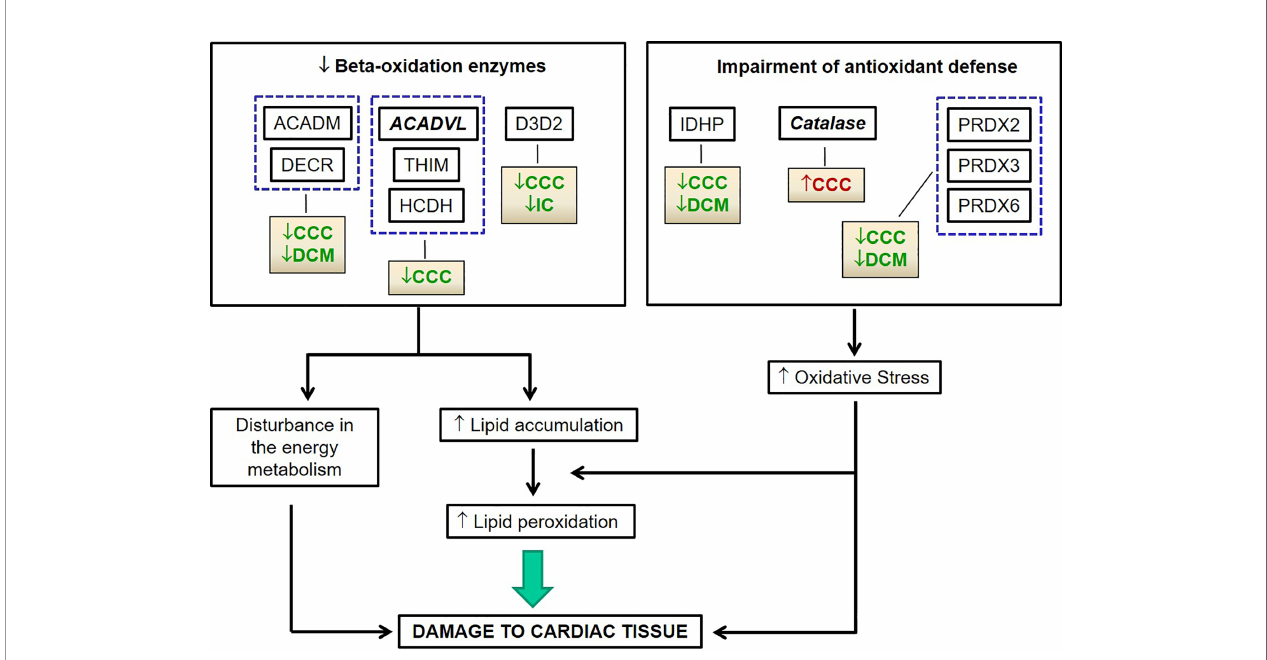
FIGURE 7 | Hypothetical chain of events subsequent to reduced beta-oxidation and oxidative stress related proteins in CCC myocardium leading to cardiac